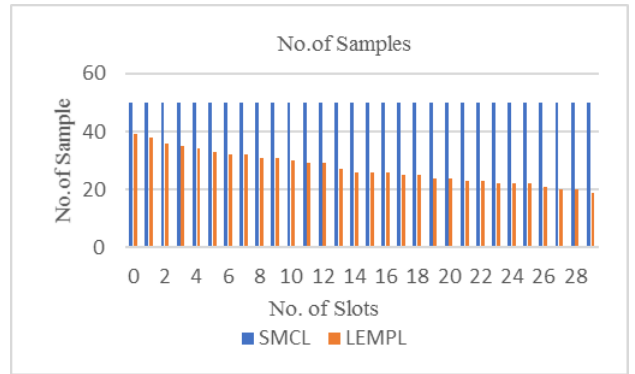
Figure 2. Localization Error (Mobile Nodes n=100, Anchor Nodes N=10)